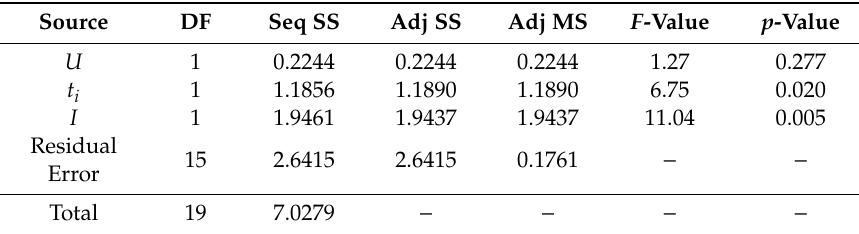
Table 10. ANOVA for the surface roughness parameter Ra .